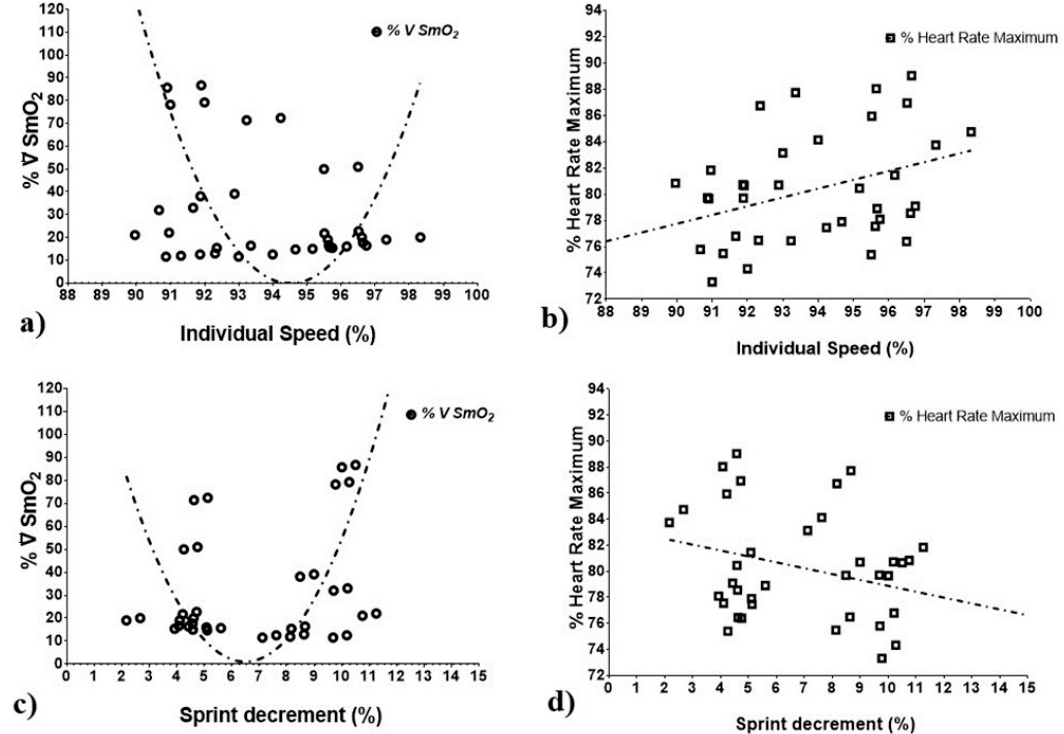
Figure 4. Association of individual speed and sprint decrement (%) with muscle oxygen extraction and maximum heart rate (%). Graphs a) Non-linear regression analysis between ▽ % SmO2 and individual speed (%). Graphs b) Linear regression analysis between %HRmax and individual speed (%). Graphs c) Non-linear regression analysis between ▽ %SmO2 and sprint decrement (%). Graphs d) linear regression analysis between %HRmax and sprint decrement (%).